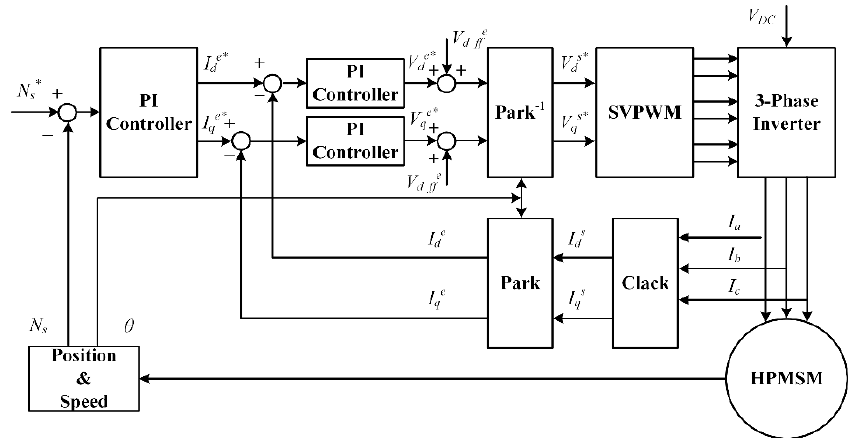
Figure 2. Block diagram for dynamic simulation of the HPMSM. Table 3. Major harmonics order of phase current by PWM.